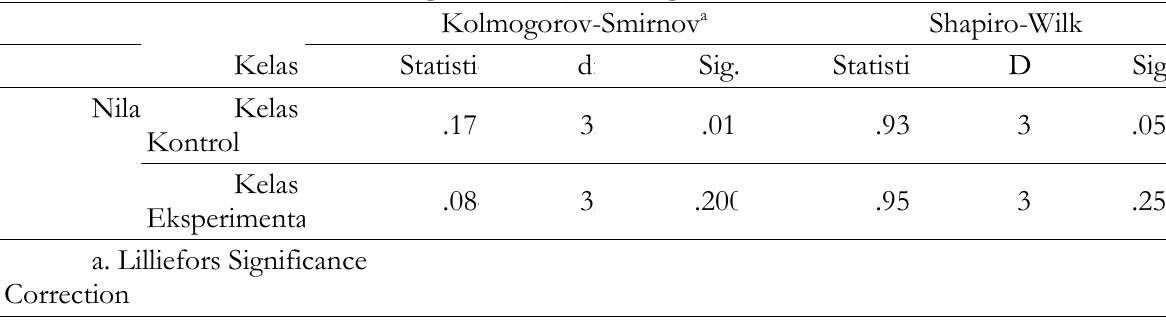
TABLE 4.10 The Result of Testing Normality Writing Post-Test Tests of